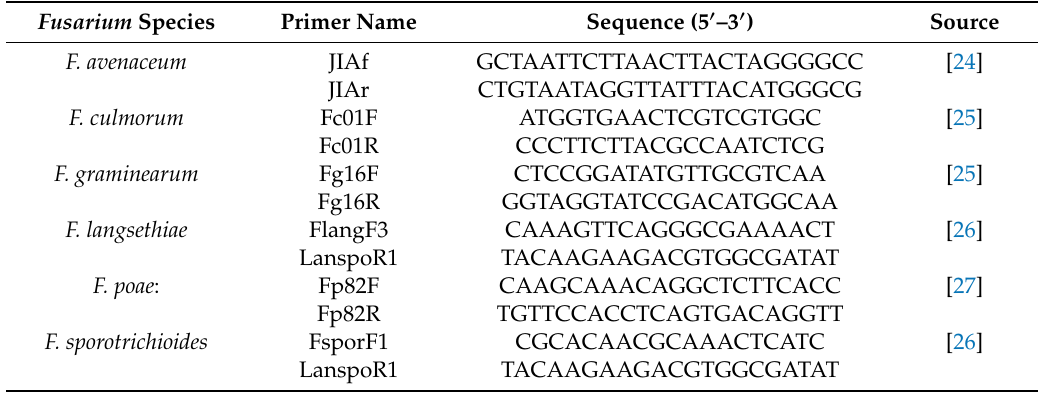
Table 2. Sequences and names of Fusarium species specific